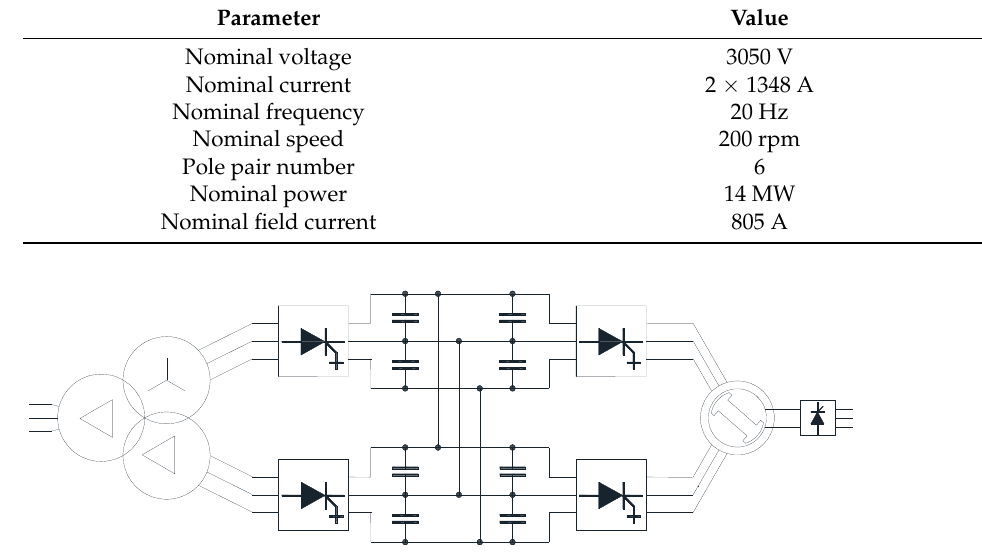
Figure 7. Power part configuration of the MV drive unit.